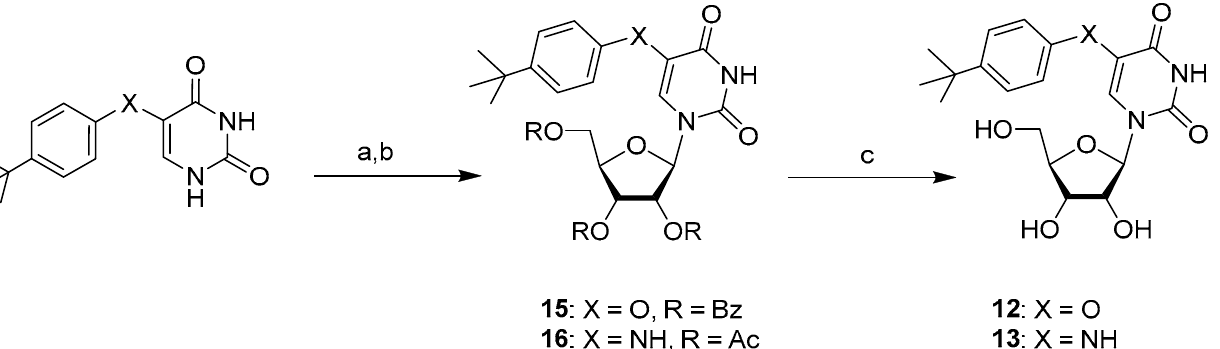
Figure 2. Directions of 1-(4’-hydroxy-2’-cyclopenten-1-yl)-6-(4-tert-butylphenyl)-3H-pyrrolo [2,3- d]-pyrimidine-2-one (compound 2 )